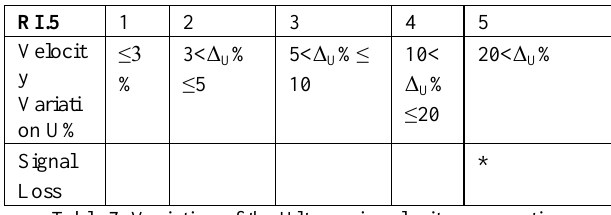
Table 7. Variation of the Ultrasonic velocity propagation  Environment characterization